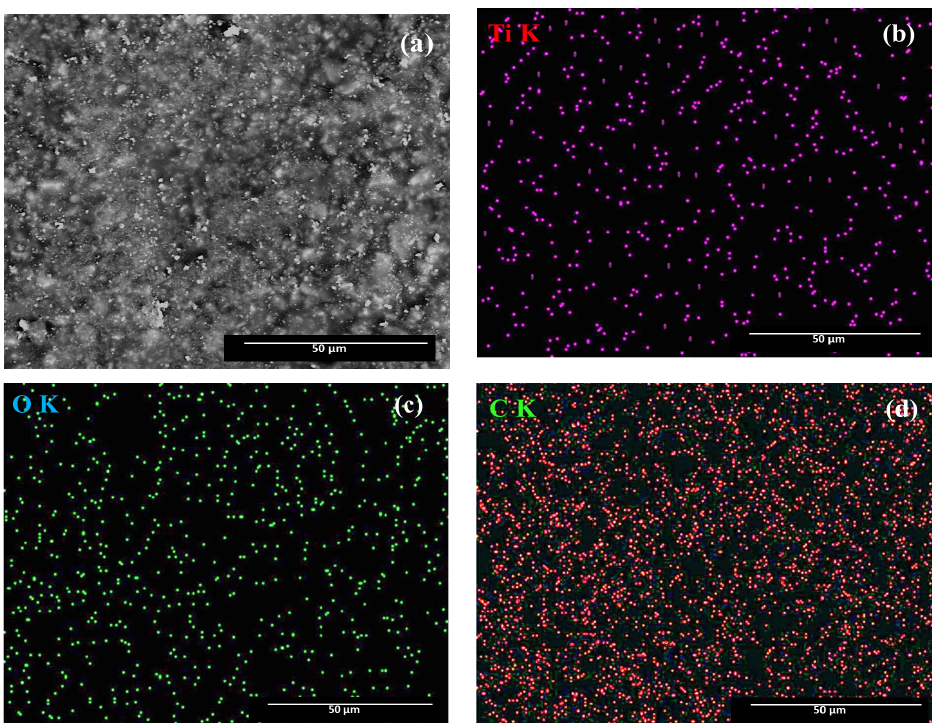
Figure 3. ( a ) SEM image of TiO 2 dispersed nanoparticle in the epoxy primer; EDX mapping and elemental analysis, including ( b ) titanium, ( c ) oxygen, and ( d ) carbon elemental